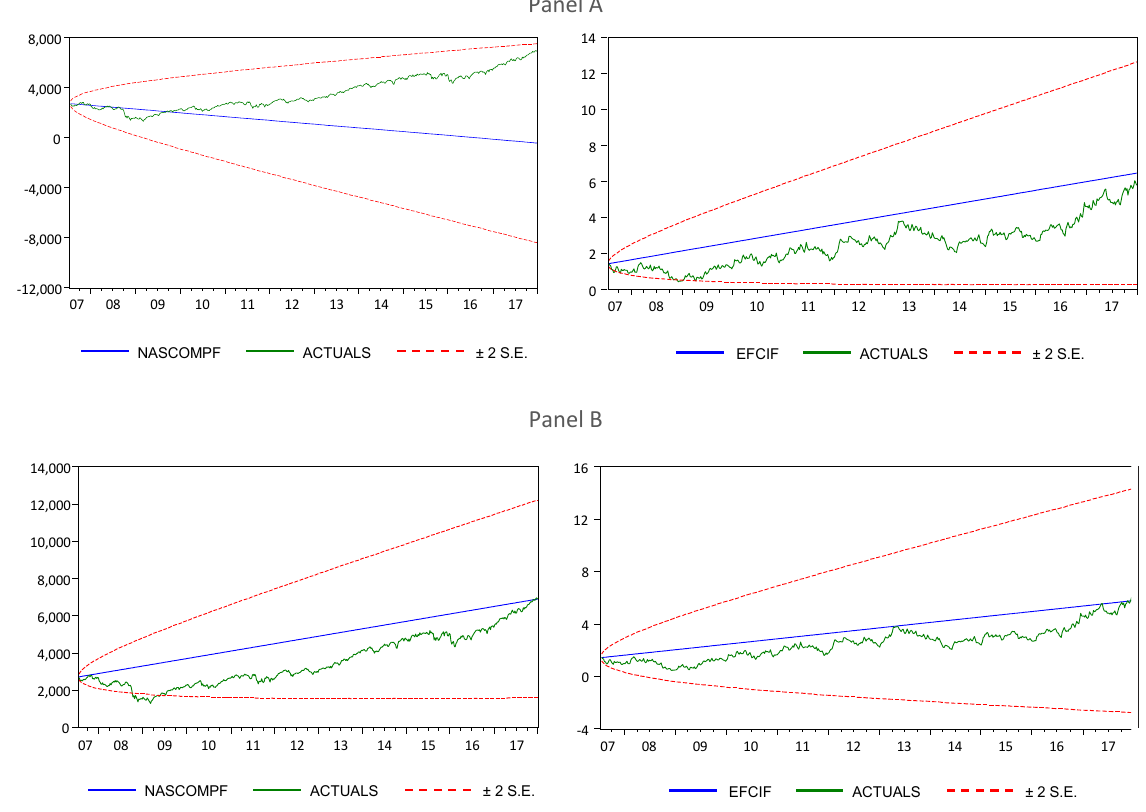
Figure 6. Actual and forecasted Nasdaq Composite Index and EFCI values